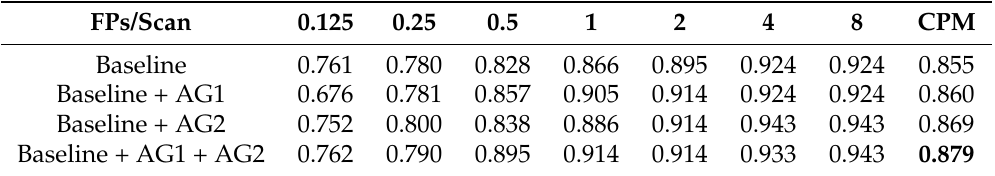
Figure 7. FROC curves obtained by the proposed lung nodule detection network and its degraded versions. Table 5. Comparison of different methods with the improved